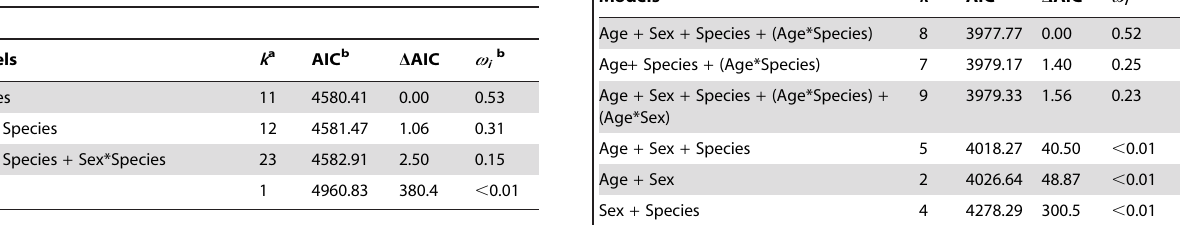
Table 1. Logistic regression models of variation in avian influenza virus (AIV) seroprevalence in adult waterfowl sampled in Alaska, USA, 1998–2010 ( n =3,588).